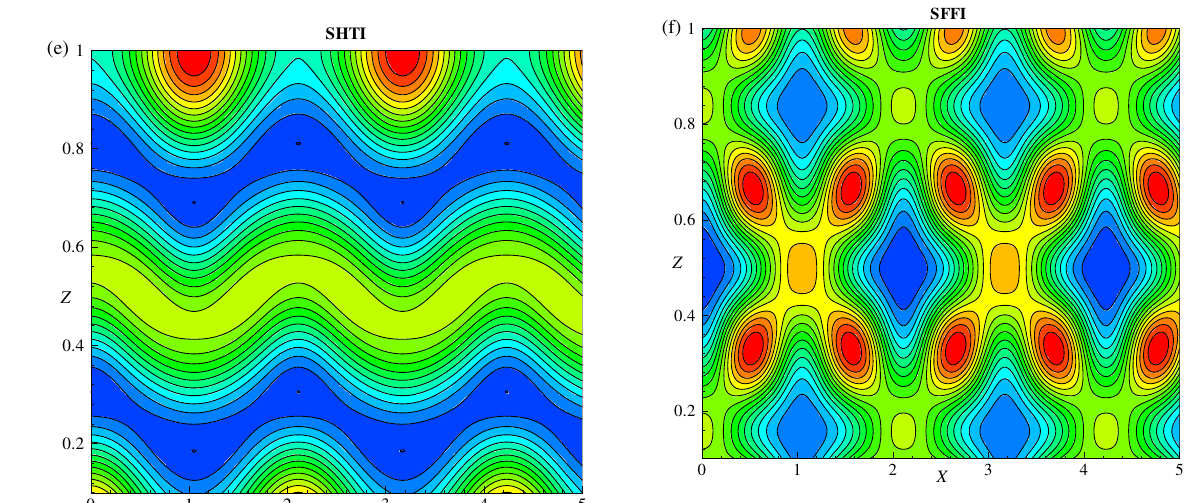
Figure 19. Local entropy generation due to heat transfer (SHTI) and fluid friction (SFFI) for Le = 0.04, ψ = − 0.03, χ = 0.2, t = 0.1 and φ = 10 − 2 , ( a , b ) R (cid:39) R co ( c , d ) R = 5 R co and ( e , f ) R = 9 R co